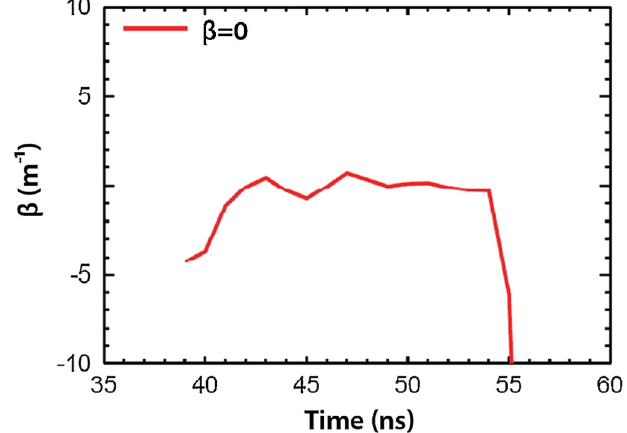
FIG. 7. (Color) Retrapping parameter, (cid:2) , versus time for a high- voltage constant electron flow profile. The plateau region of the curve represents the time period of electron flow predominately parallel to the cathode conductor surface. Within the numerical fluctuations, the retrapping rate is essentially constant over the time of interest, although the magnitude of the electron flow is changing